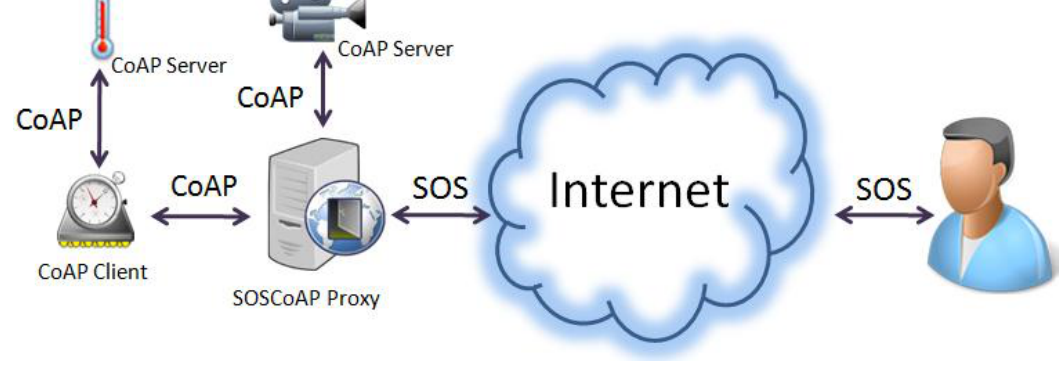
Figure 6. High level view of the SOS over CoAP